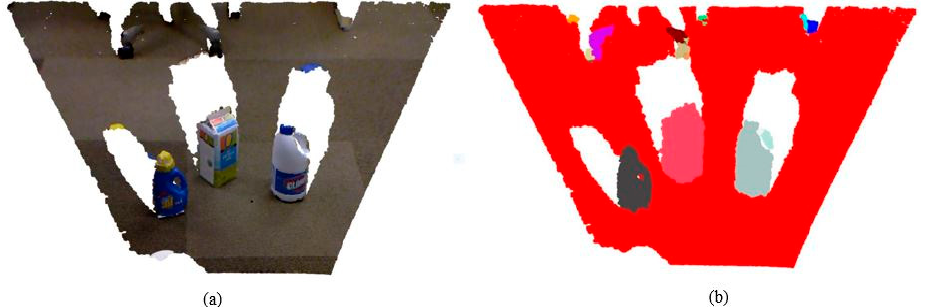
Figure 9. The segmentation result of our method on a point cloud containing a table surface and several objects (bottles and boxes): ( a ) the original point cloud with real colors, and ( b ) the segmentation result with different objects labeled in different colors, respectively.